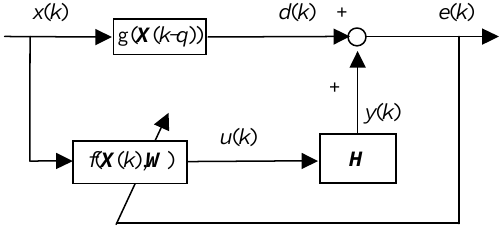
Fig. 2. Block diagram of a nonlinear control